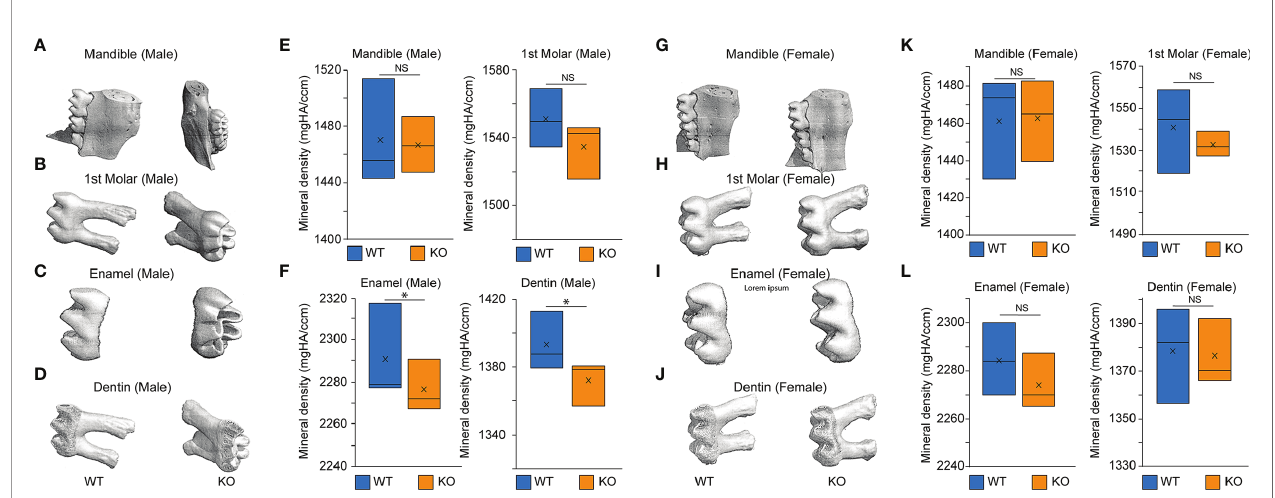
FIGURE 6 | MicroCT of the mandible, fi rst molar, enamel, and dentin in 2-month-old Baf45a conditional knockout mice compared to wild type. Baf45a f/f was deleted at embryonic day E9.5 mating with Prrx1-Cre mice. (A – F) Homozygous Baf45a f/f (n = 3) and age-matched mice of 2 months were analyzed. Mice were euthanized, and teeth were extracted and stored in ethanol. The bone volume of the whole molar, the outer enamel layer, the inner dentin layer, and the whole mandible from WT and Baf45a KO male mice, (G – L) Bone volume of the whole molar, the outer enamel layer, the inner dentin layer, and the whole mandible from WT and Baf45a KO female mice. Males (n=3) and females (n=3) at 2-months littermates. Signi fi cance was determined using Student ’ s one-tailed t-test: *p < 0.05; NS (non signi fi cant). Mineral density